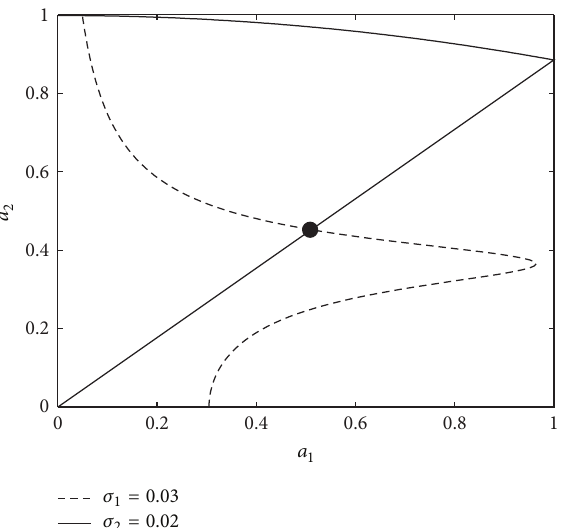
Figure 4: Steady-state solution when 𝜎 1 = 0.03 [rad ⋅ s −1 ] and 𝜎 2 = 0.02 [rad ⋅ s −1 ].